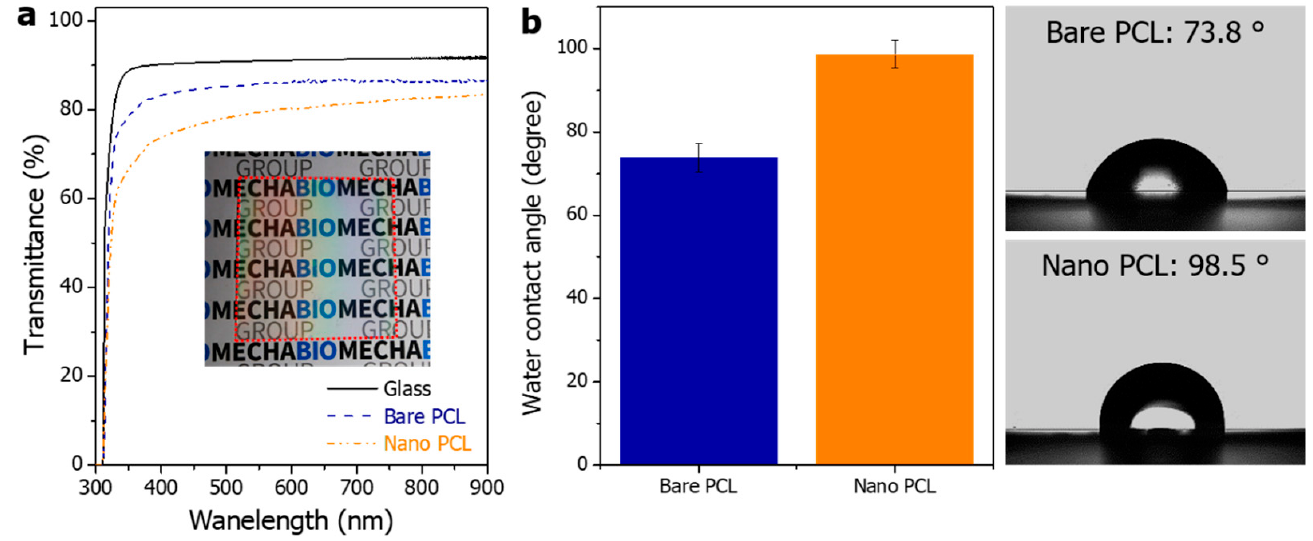
Figure 4. ( a ) Optical transmittance of the bare and nanopillared PCL film in the wavelength range of 300–900 nm. ( b ) Water contact angle values of the bare and nanopillared PCL surface (Nano PCL: nanopillared PCL).